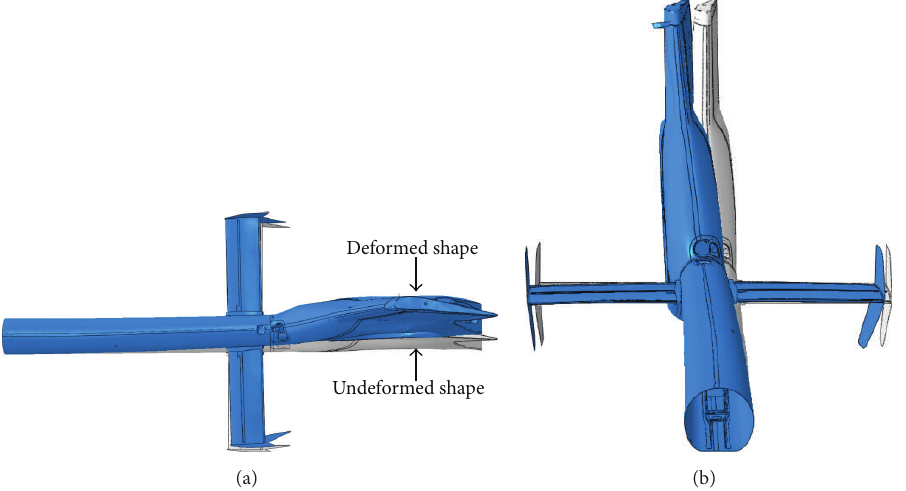
Figure 7: Illustration of maximum deflection of tail boom during shock wave loading from missile launch from top view (a) and front view (b); deformation scale factor =